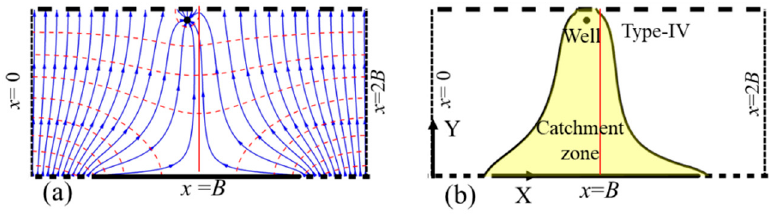
Figure 6. The flow net ( a ) and catchment zone ( b ) of type-IV.